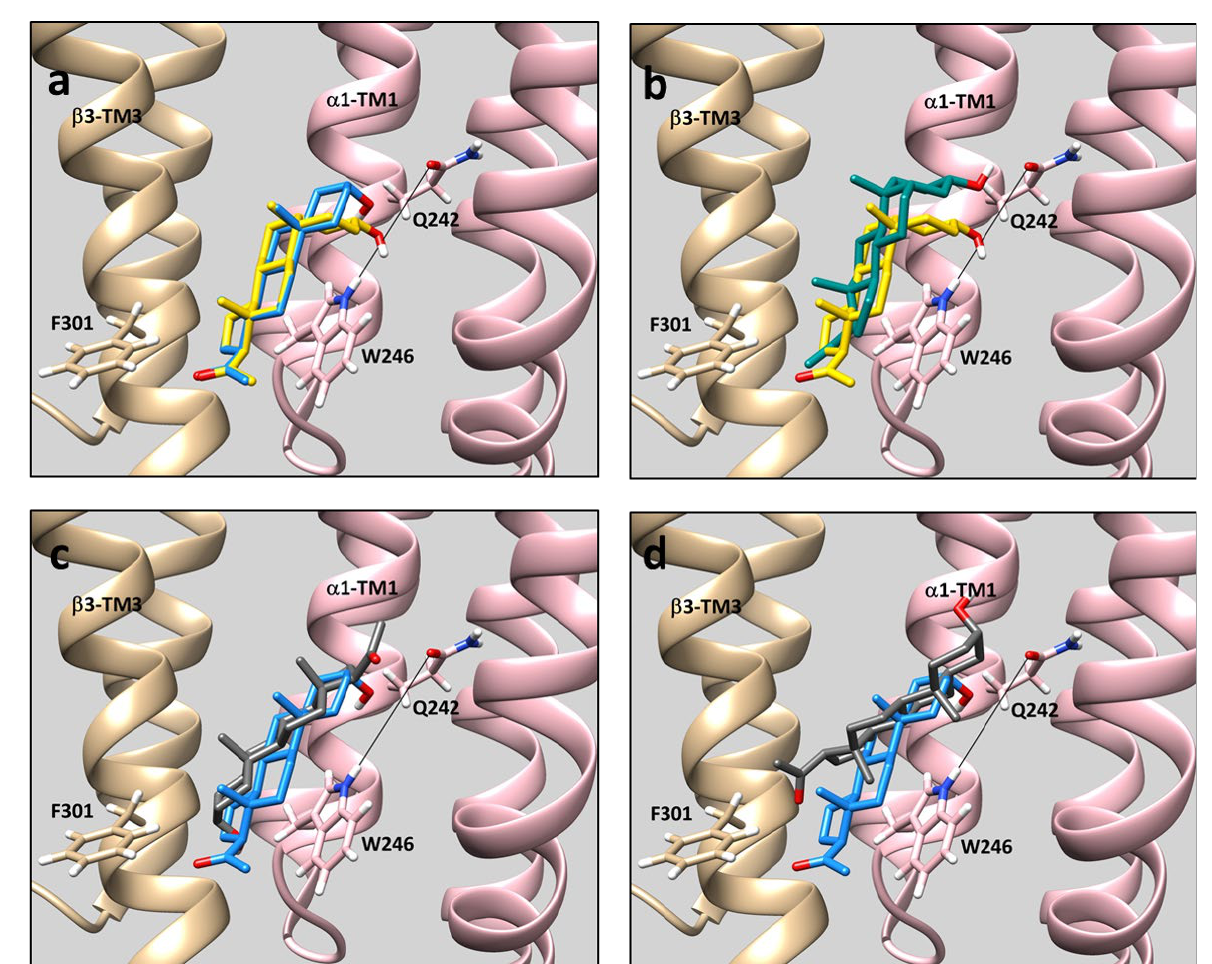
Figure 3. Comparison of steroid docking poses in the β 3 /α 1 intersubunit binding site of the GABA A receptor using the cryo-EM structure (PDB 6HUO) of a α 1 β 3 γ 2 GABA A receptor. The β 3 subunit is shown in tan and the α 1 subunit in pink. Sidechains of the α 1 (Q242) and α 1 (W246) residues are shown connected by a line indicating the axis of the coordinated hydrogen bonds formed by these two residues with the steroid 3-hydroxy group. The side chain of β 3 (F301), a residue known to line the steroid binding site is also shown. The structure of ALLO is shown in blue, ent -ALLO in grey, PREG in yellow and ent -PREG in green. ( a ) ALLO and PREG in their lowest energy poses. (Both steroids are in Orientation #1 (See Table 1)). The steroid rings, methyl groups and methyl ketones are aligned with the 3-hydroxy groups of both steroids positioned to form hydrogen bonds with Q242 and W246. ( b ) PREG and ent -PREG in their lowest energy poses. (Both steroids are in Orientation #1.) The methyl groups and methyl ketones of both steroids are similarly oriented and the 3-hydroxy groups of both steroids are positioned to hydrogen bond with Q242. ( c ) ALLO and ent -ALLO in their lowest energy poses. While the methyl groups of the two steroids are similarly positioned, the 3-hydroxyl group of ent -ALLO is oriented 180 ◦ from ALLO and points to F301; it is thus not positioned to form a hydrogen bond with Q242 or W246. (ALLO is in Orientation #1, whereas ent -ALLO is in Orientation #2.) ( d ) Comparison of ALLO (lowest energy pose) with ent -ALLO in the lowest energy pose in which the 3-hydroxy group points toward the α 1 subunit. (Both steroids are in Orientation #1.) The methyl groups of the two steroids are oriented in opposite directions and the 3-hydroxy group of ent -ALLO is pointing away from Q242. The absence of a hydrogen bond and the malposition of the methyl groups likely makes this an energetically unfavorable pose for ent -ALLO binding. The Vina docking scores for the steroids in each pose are shown in Table